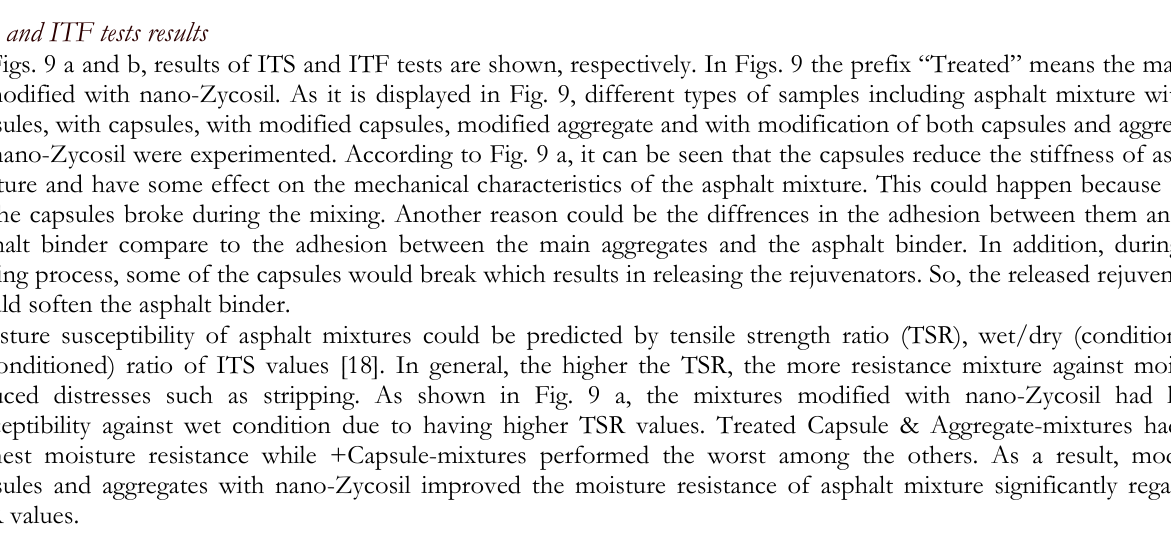
Figure 8: TGA diagrams of encapsulated